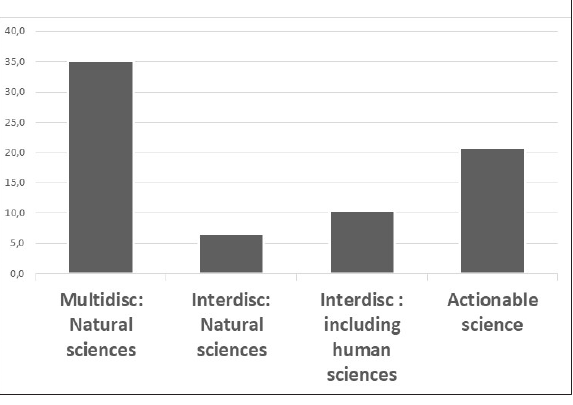
Figure 3: Percentage of presentations ( n =182) that were multidisciplinary (Multidisc) or interdisciplinary (Interdisc) and that were assessed to be presenting actionable